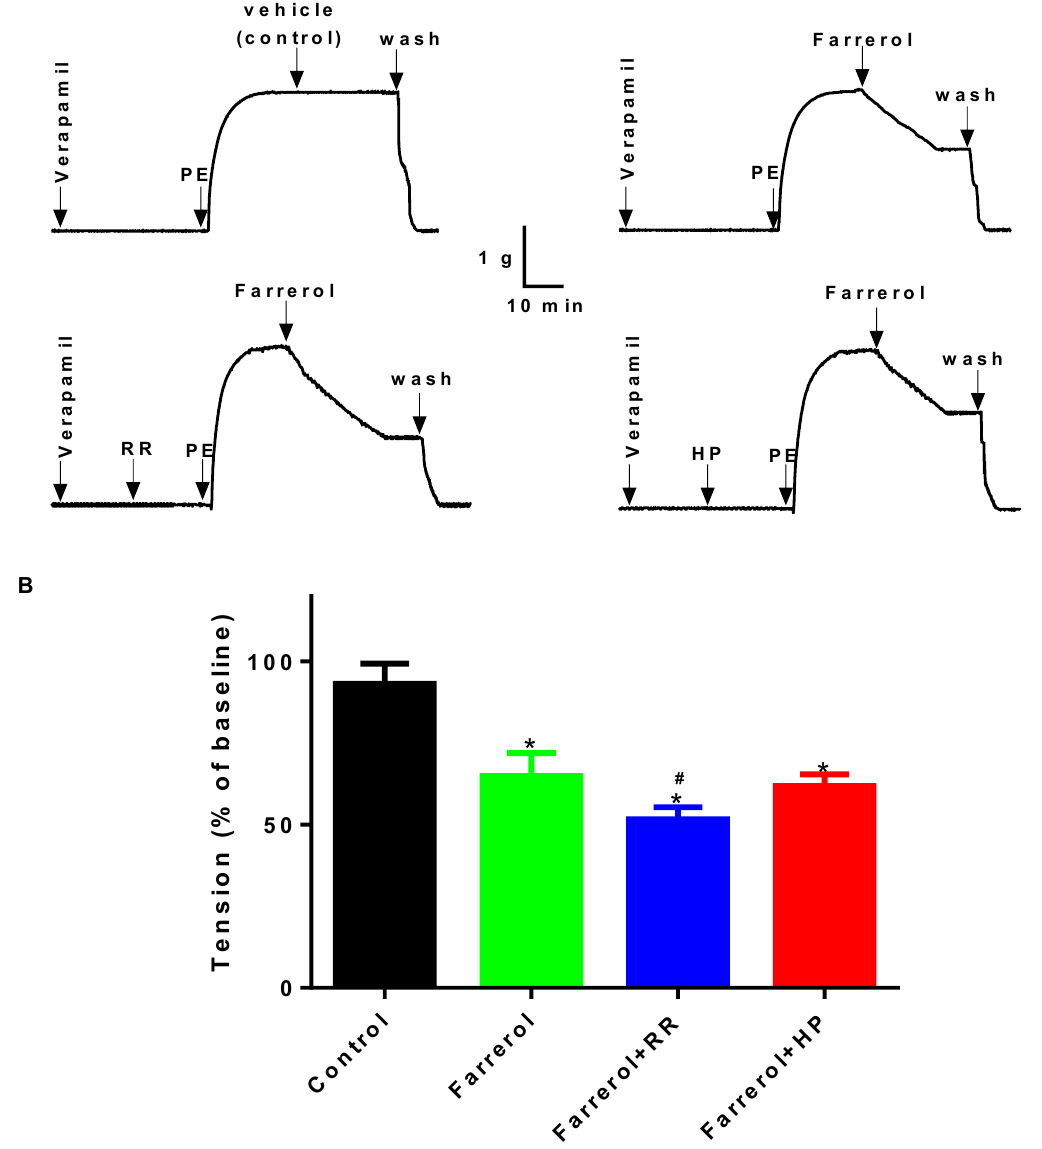
Figure 4. Effects of farrerol at 35.94 µM in rat aortic ring contracted with PE (1 μM) after verapamil (1 μM) pretreatment in the absence (control) or the presence of ruthenium red (RR) (10 μM) or heparin (HP) (50 mg/L). ( A ) Original tension tracings; ( B ) Data are expressed as means ± SD. ( n = 7−10). * p < 0.05, vs . control; # p < 0.05, vs. farrerol. The statistical analysis used the Anova with Dunnet’s post hoc